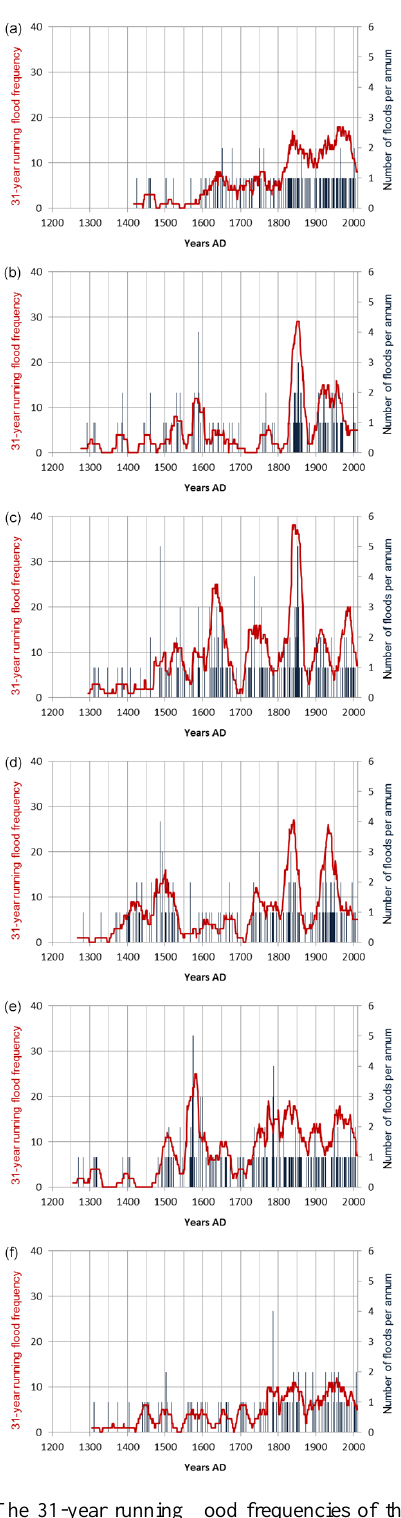
Figure 3. The 31-year running flood frequencies of the Bavarian Foreland rivers (red graph). Right ordinate: dark columns show the annual flood frequencies. (a) Iller, (b) Wertach, (c) Lech, (d) Isar, (e) Salzach, and (f) Inn.